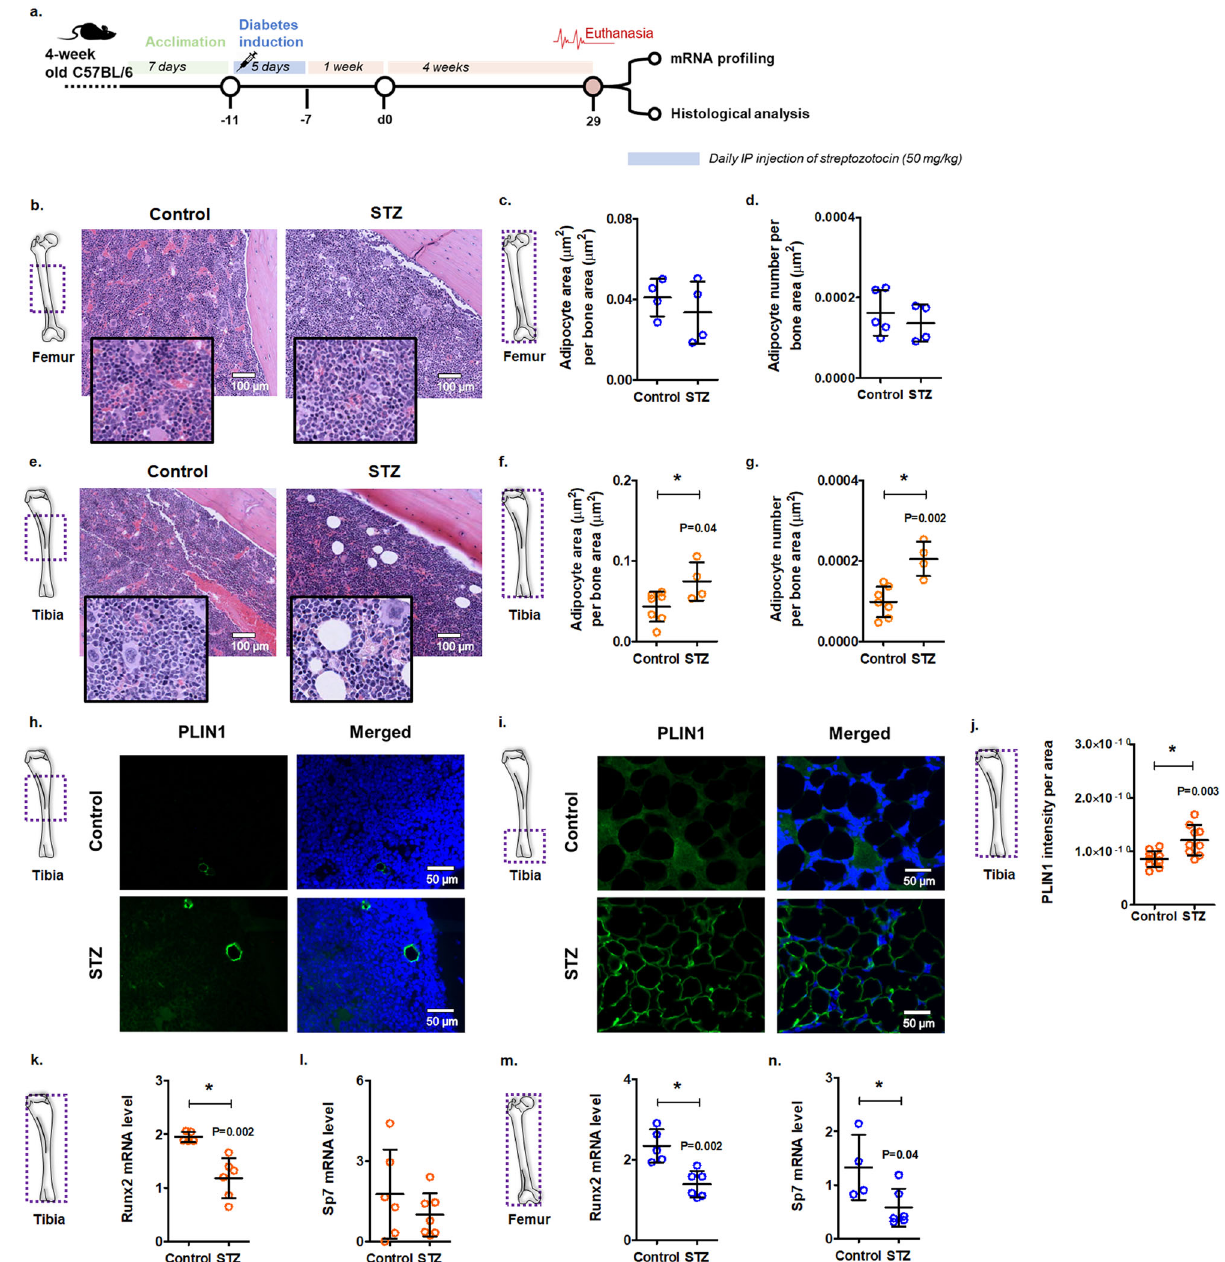
Fig. 1 Streptozotocin-induced diabetes enhances adipocyte number and area in tibiae of mice at 1 month. a Experimental scheme for diabetic mouse study. Diabetes was induced in C57BL/6 mice with daily intraperitoneal injections of streptozotocin (STZ; 50 mg/kg) for 5 consecutive days. Non-diabetic control mice received an equal volume of citrate buffer. Blood glucose levels were checked 1 week after the last STZ injection to con fi rm hyperglycemia (d0). b Representative H&E-stained images of the mouse femur [scale bar = 100 μ m]. Inserts showing higher magni fi cation. Quanti fi cation of adipocyte area per bone area ( c ) and adipocyte number per bone area ( d ) in the femurs. Parameters were measured using MarrowQuant [Mean ± SD; n = 4 (5 for control in panel d ); each data point represents a mouse; two-tailed student ’ s t -test: * p < 0.05]. e Representative images of the H&E-stained mouse tibia [scale bar = 100 μ m]. Inserts showing higher magni fi cation. Quanti fi cation of adipocyte area per bone area ( f ) and adipocyte number per bone area ( g ) in the tibiae [Mean± SD; n = 7 control and 4 STZ in panels f and g ; each data point represents a mouse; two-tailed student ’ s t -test: * p < 0.05]. Immuno fl uorescence staining of mouse tibia for perilipin-1 (PLIN1; green). Sections were counterstained with DAPI (blue) [scale bar = 50 μ m]. Figure showing shaft ( h ) and distal regions ( i ) of the tibia. j Quanti fi cation of PLIN1 intensity per area, as determined by ImageJ [Mean ± SD; n = 10 control and 9 STZ; two-tailed student ’ s t -test: * p < 0.05]. mRNA levels of osteogenesis-associated genes were measured in the tibiae ( k , l ) and femurs ( m , n ) of control and diabetic (STZ) mice [Data normalized to Actb and Gapdh ; Mean± SD; n = 5 control and 6 STZ in panel k , 4 control and 6 STZ in panel l , 5 control and 6 STZ in panel m ; each data point represents a mouse; two-tailed student ’ s t -test: * p < 0.05].